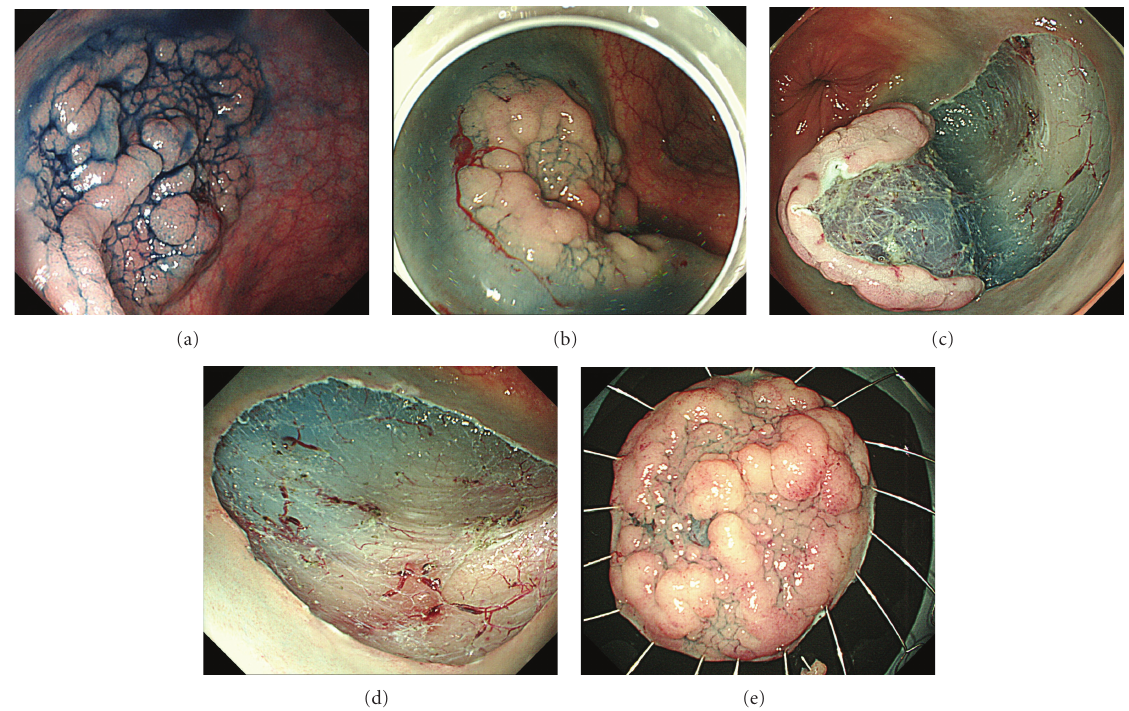
Figure 1: (a) Conventional endoscopic view with indigo carmine dye spray revealed laterally spreading tumor (LST), 40 mm in diameter, located in the rectum. The border was well demarcated. (b) After injection of sodium hyaluronate. (c) Mucosal incision and dissection. (d) Rectal ulcer after ESD. (e) Resected specimen was 45mm ×